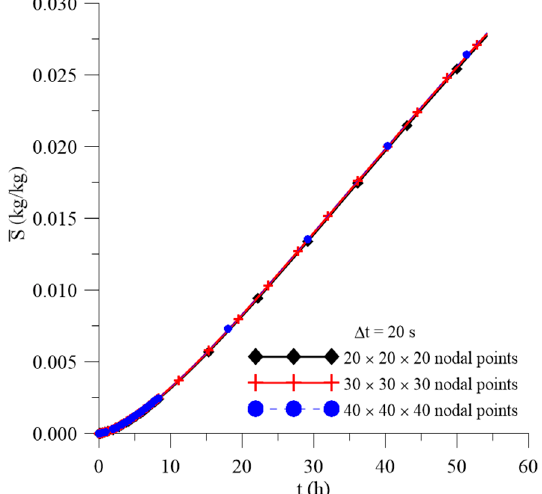
Figure 7. Transient behavior of the average entrapped solute concentration for different meshes.